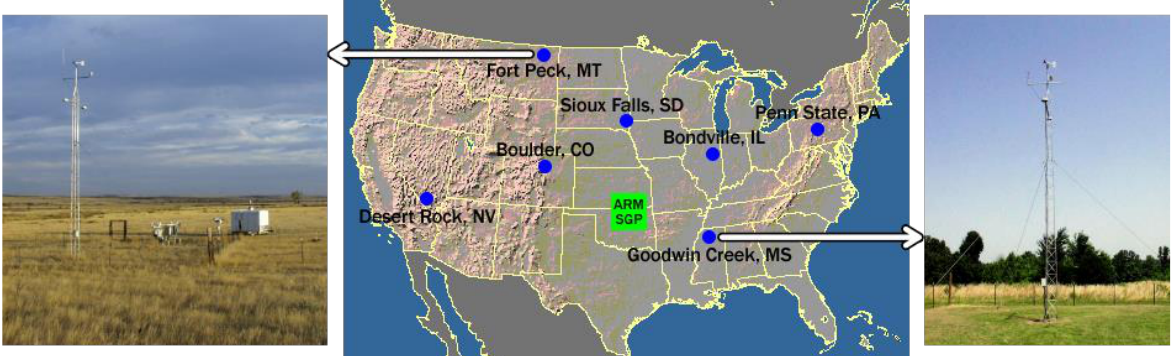
Figure 2. General overview of the SURFRAD network and demonstration of two stations (FPK and GWN) utilized in the LST analysis (Source: